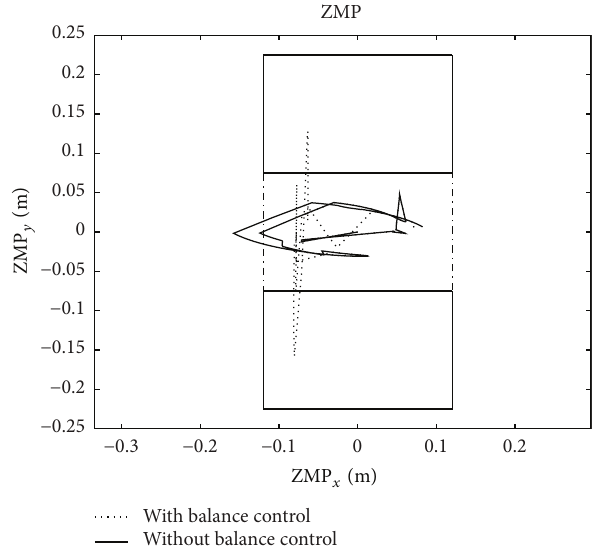
Figure 8: ZMP curve of the